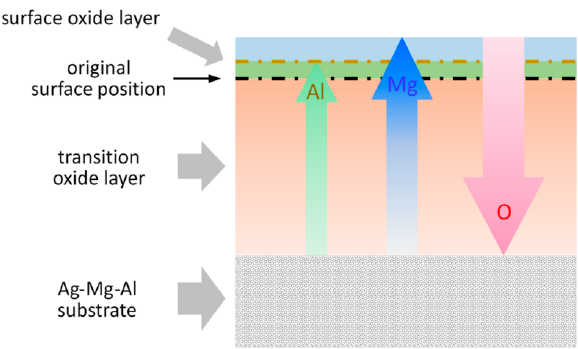
Figure 5. Schematic diagram illustrating the element migration during activation of the Ag-2Mg-2Al alloy. A layer of alumina-containing MgO is developed beneath the top MgO layer due to relatively slower migration rates for Al atoms compared to that for Mg atoms during activation.